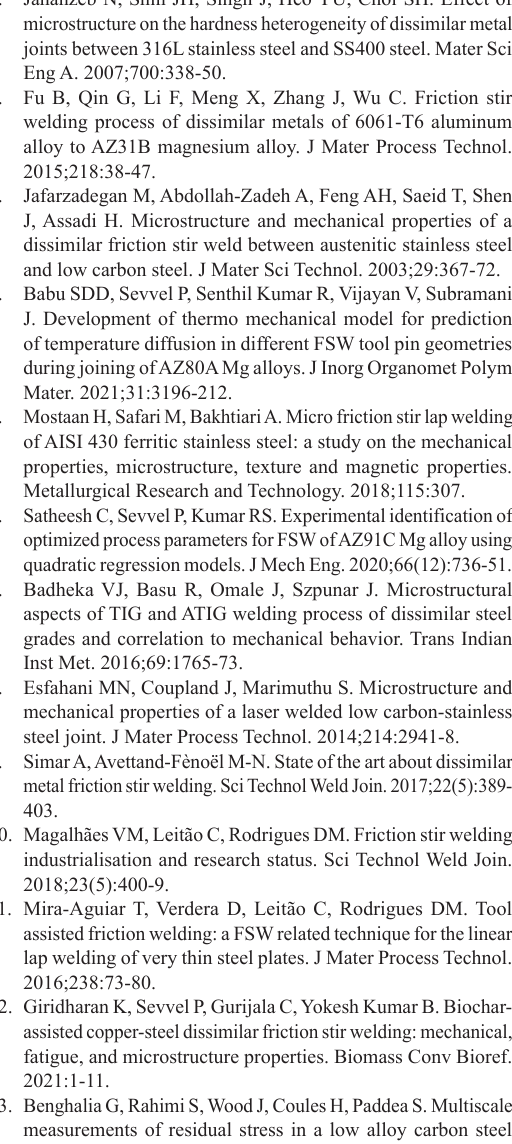
Figure 11. Axial force generation during FSW